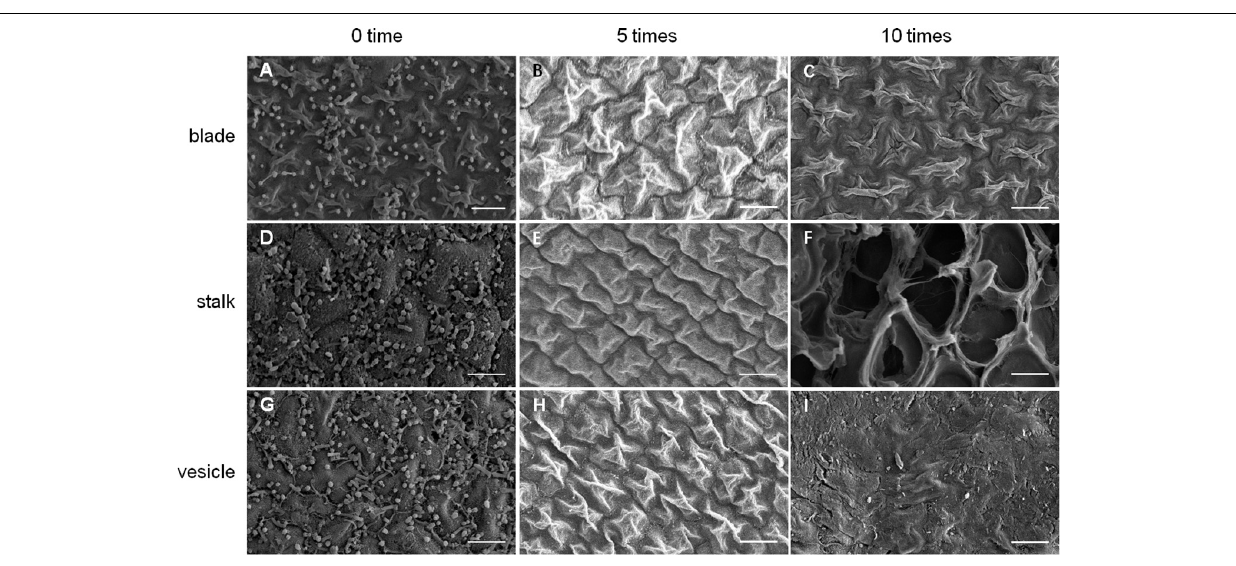
FIGURE 6 | SEM detection for removal effects of epiphytic bacteria from three kinds of S. horneri tissues. (A) Blade blank control. (B) Blade vortexed for 5 times. (C) Blade vortexed for 10 times. (D) Stalk blank control. (E) Stalk vortexed for 5 times. (F) Stalk vortexed for 10 times. (G) Vesicle blank control. (H) Vesicle vortexed for 5 times. (I) Vesicle vortexed for 10 times. Scale bars = 5 µ